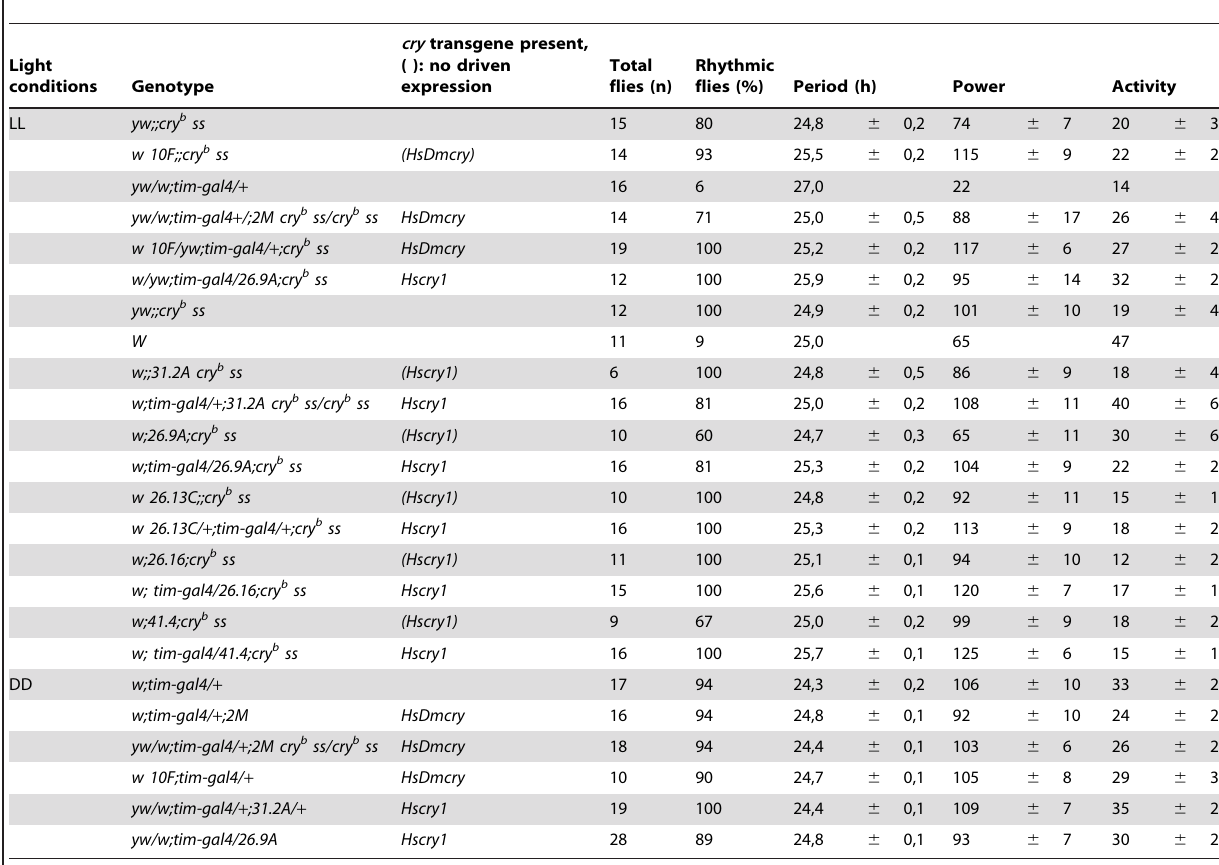
Table 1. Heterologous CRY expression does not restore a wild-type arrhythmic phenotype to cry b mutant flies.